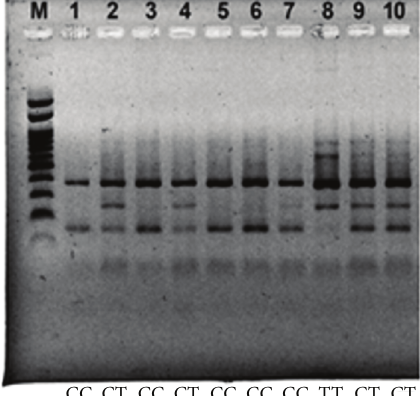
Figure 1: Renin gene C-5312T amplification. Photos of electropho- resis results (PCR product of 10 hypertensive patients), with an ethidium bromide dye on agarose 1.5%. From the left, image (M) is marker, and wells 1 to 10 are a band of renin gene polymorphism with genotypes CC, CT, and TT.